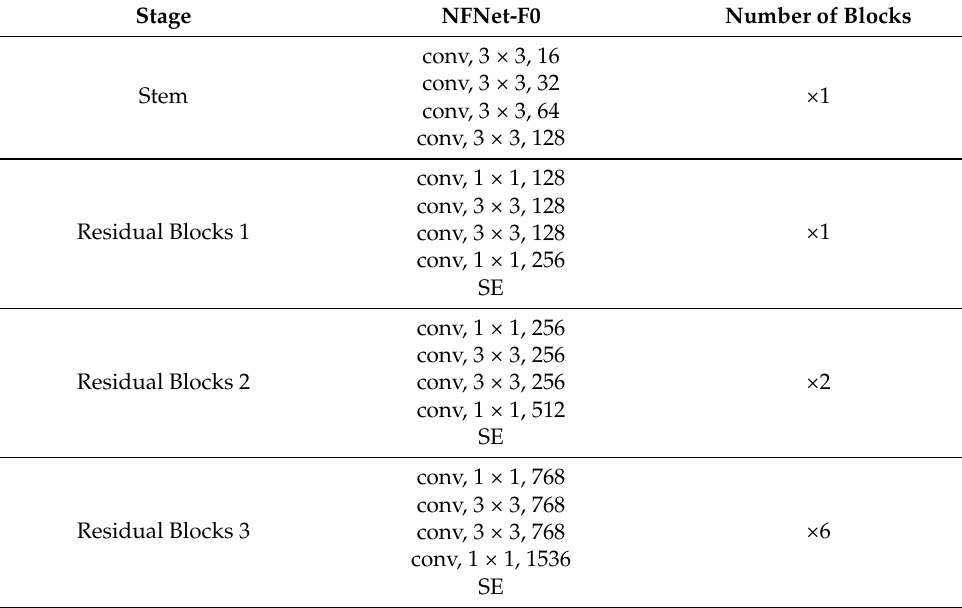
Table 3. The configuration of the NFNet-F0